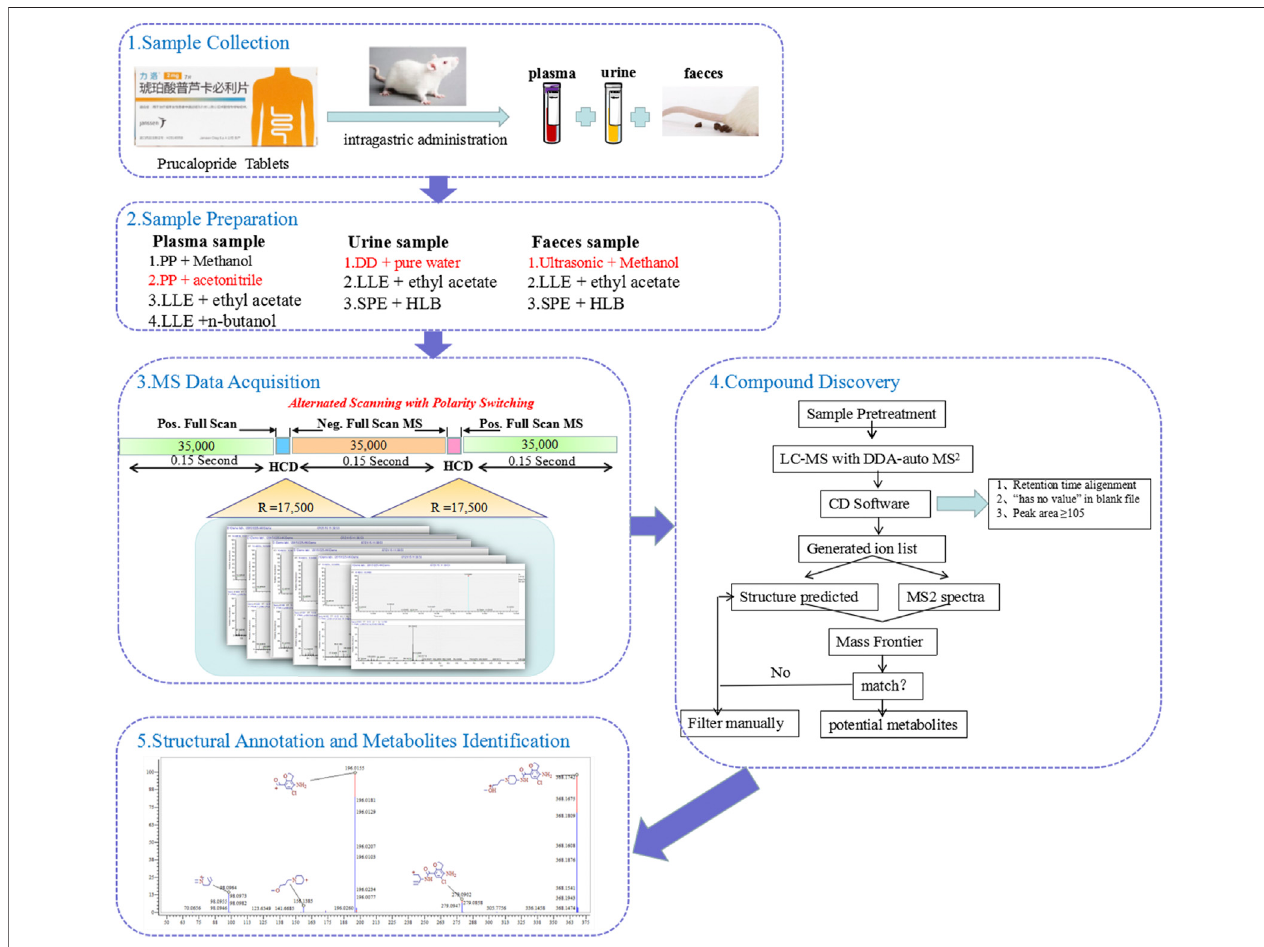
FIGURE 1 | The work fl ow of analytical strategy for metabolite identi fi cation using UHPLC-Q-Orbitrap HRMS in combination with multiple data mining techniques.